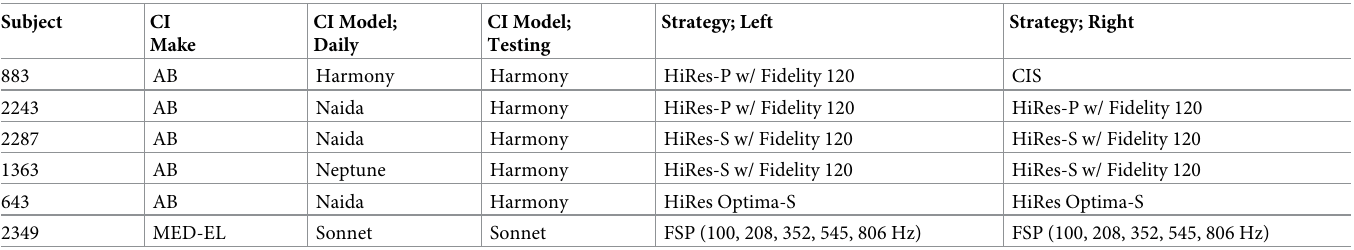
Table 2. There is one listener per row. Data include the manufacturer of participant’s CIs, the CI models the participant uses day-to-day, and the models used in the study. For the MedEl patient, the cutoff frequencies of the four lowest processing channels, in which FSP takes place, are listed beside the left and right Strategies.